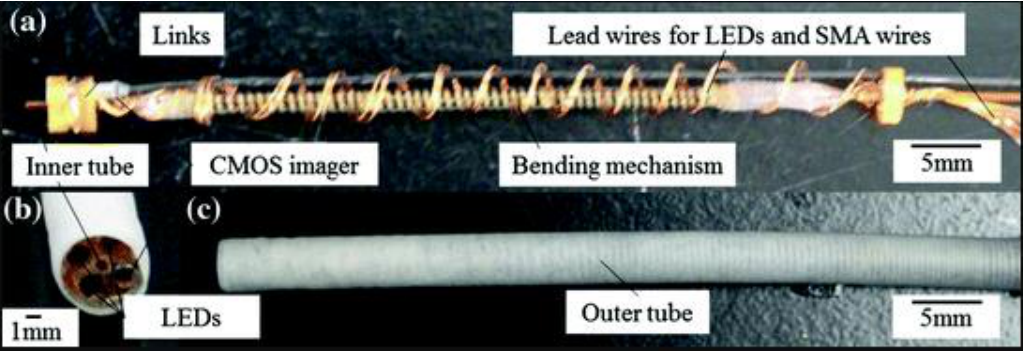
Figure 19. Endoscope actuated using shape memory alloy wires: ( a ) actuator; ( b ) front-view of developed endoscope; ( c ) outer surface of the developed endoscope (taken with the permission from [70]).